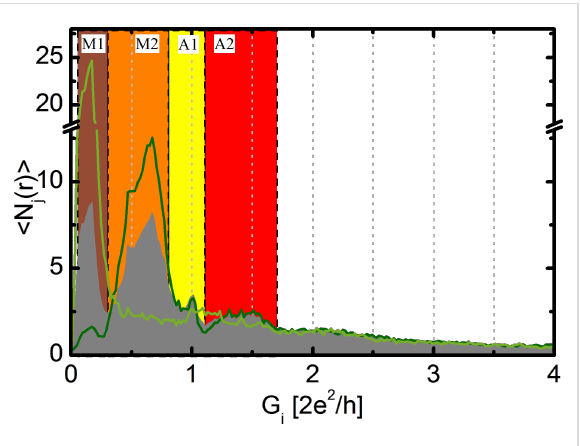
Figure 3: Conditional histograms based on double selection. First the traces are selected for which the molecular plateau in the entire M1–M2 region is longer than average, i.e., the traces corresponding to pronounced molecular junctions. The conditional histogram for these traces (grey area graph) is the same as the green line in Figure 2a. As a next step we select traces from this reduced dataset, for which the M1 (M2) region is longer than average, respectively. The light and dark green curves show the corresponding conditional histograms for the M1 and M2 region, respectively.